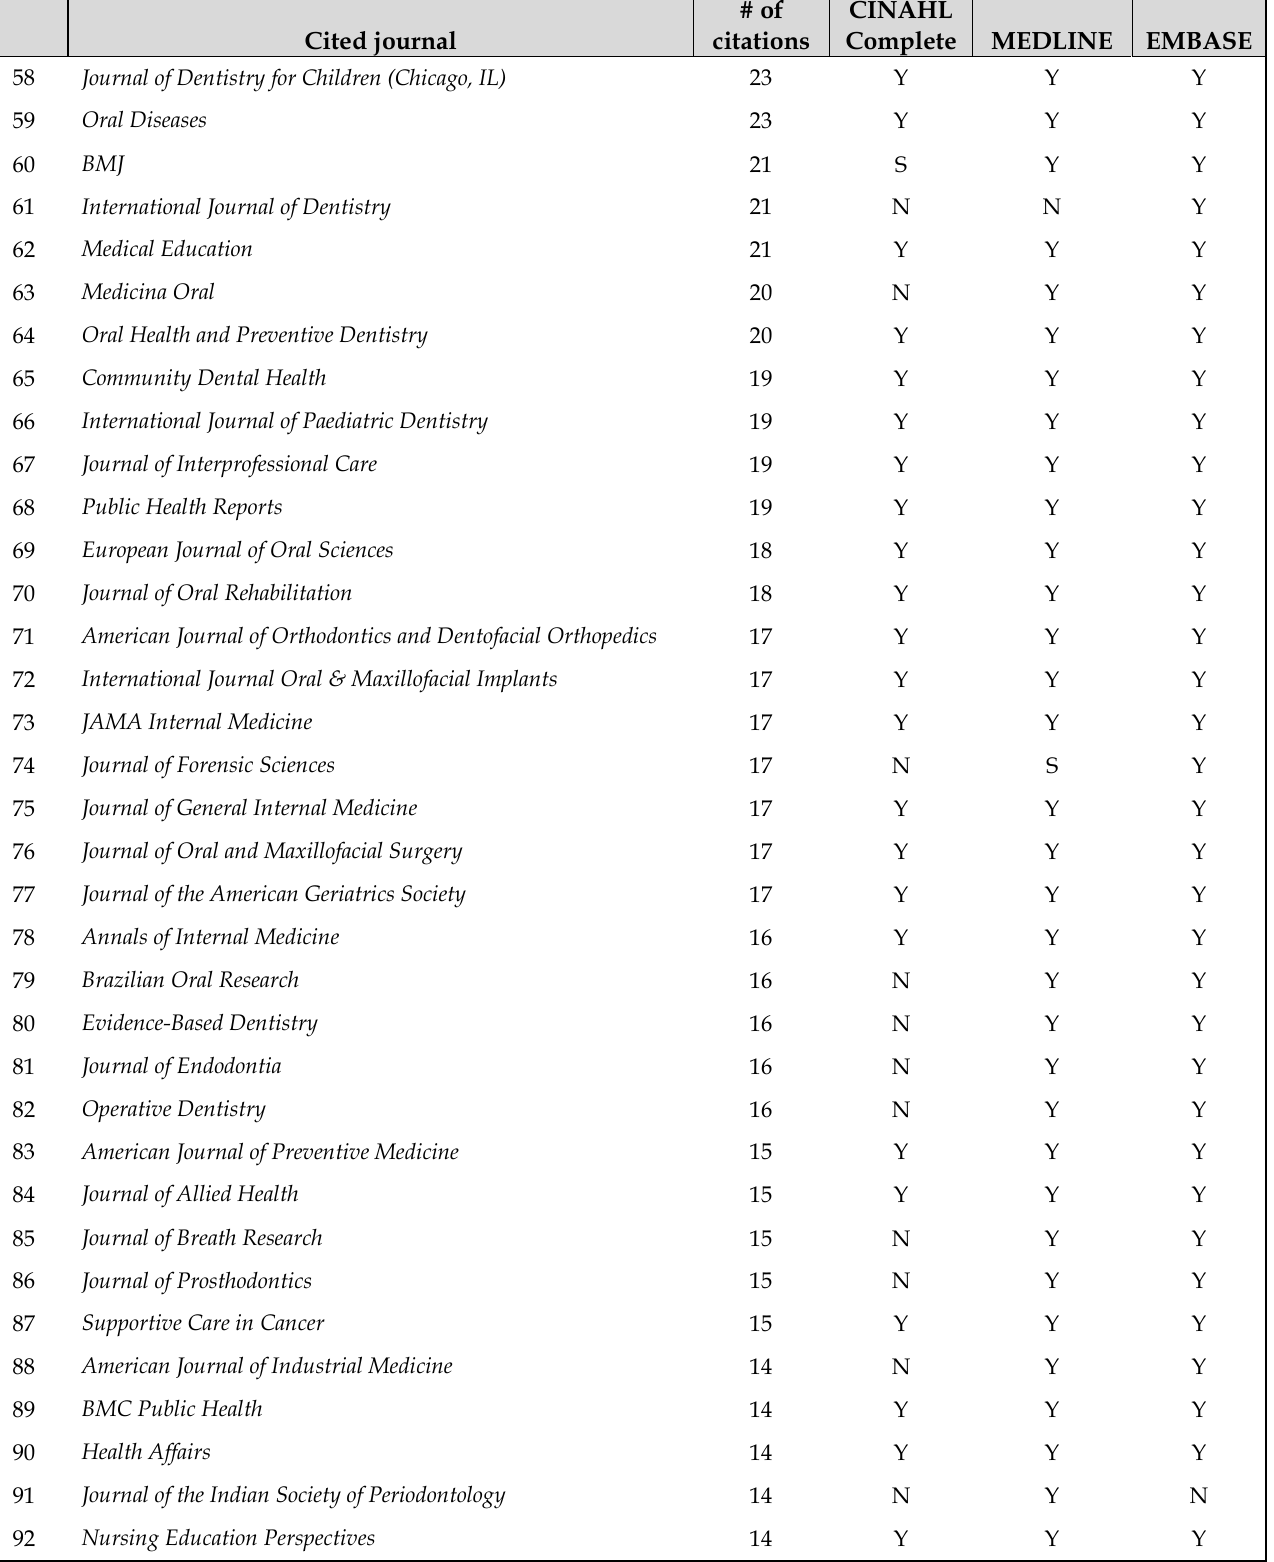
Table 4 Distribution and indexing coverage in of cited journals in Zone 1 and Zone 2